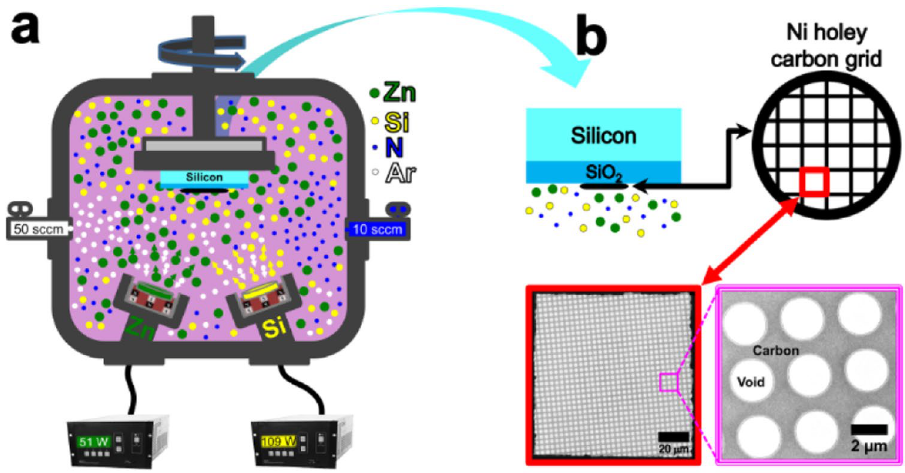
Figure 4. ( a ) Schematic setup of combinatorial sputtering for ZnSiN 2 synthesis on amorphous carbon. ( b ) The red square indicates a zoom from one grid quadrant while the magenta square shows a region containing amorphous carbon with circular